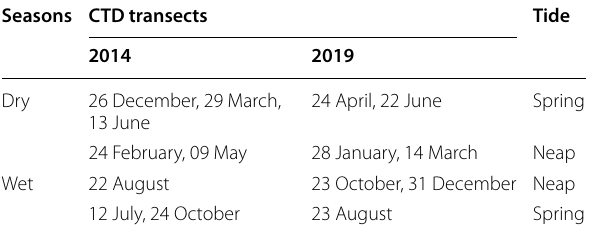
Table 1 Sampling scheme during spring and neap tides in dry and wet seasons in the Pasur River estuary Seasons CTD